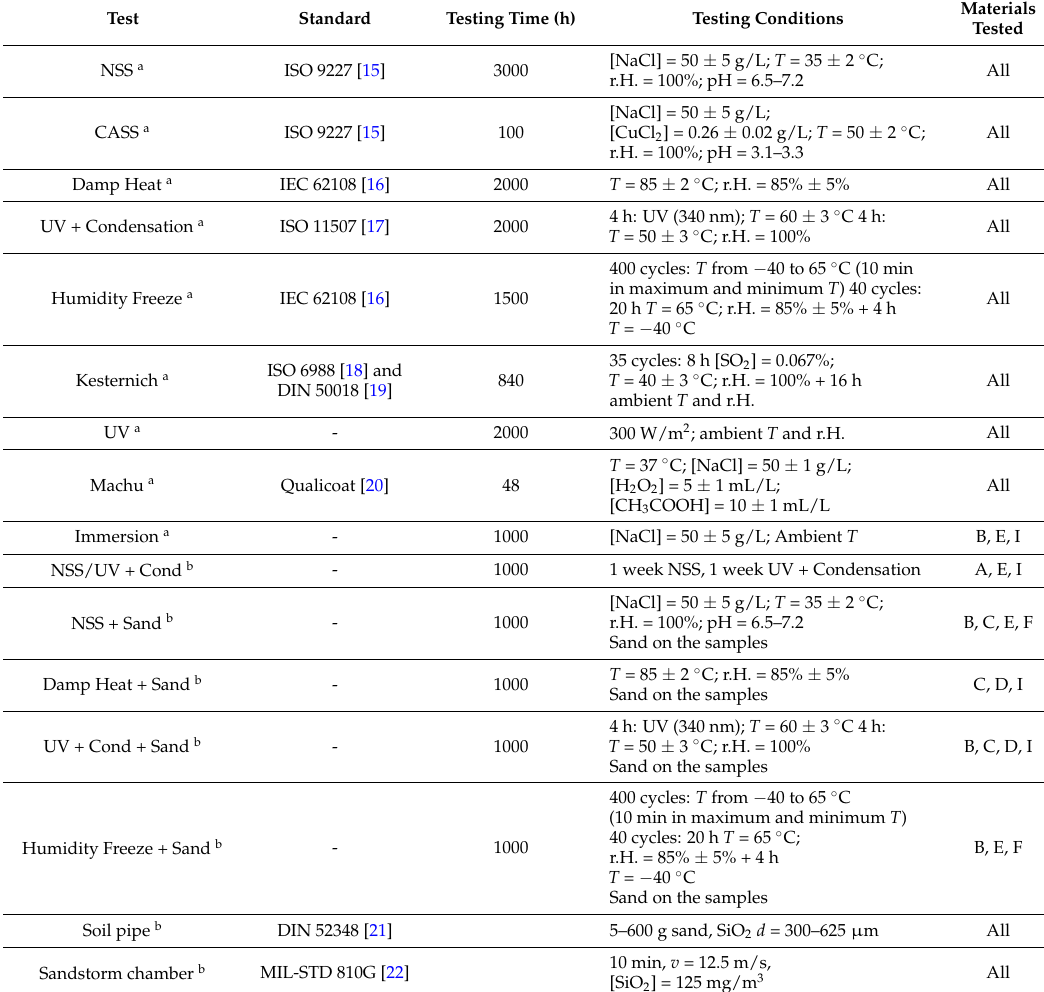
Table 2. Description of performed accelerated aging